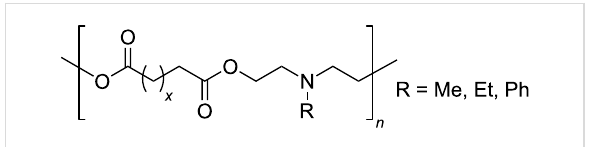
Figure 17: Polyesters obtained by CAL-B-catalyzed condensation of dicarboxylic esters and N -substituted diethanolamine.